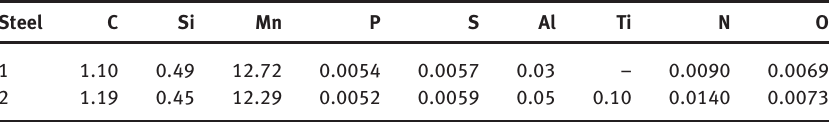
Table 1: Composition of steels examined (wt%).